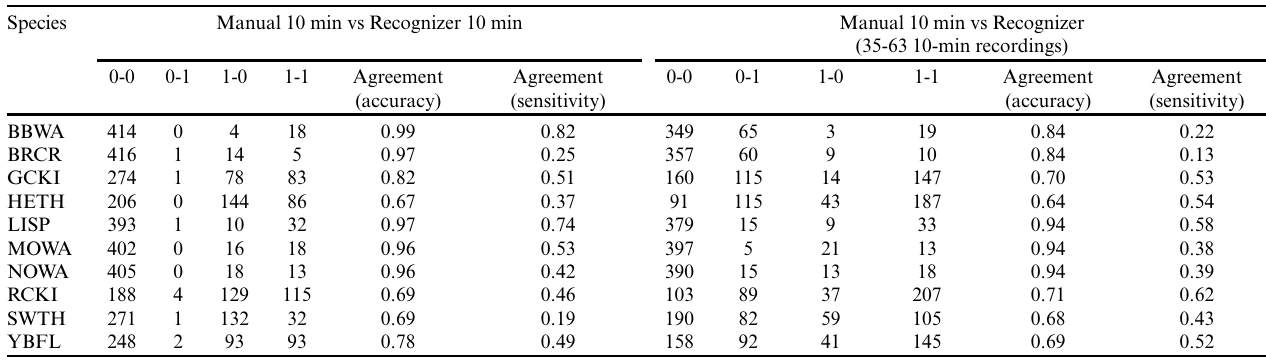
Table 7 . Summary of detection (1) and nondetection (0) patterns for two comparisons. The first compares manually interpreted 10- minute recordings against 10-minute recordings processed by a recognizer. The second comparison contrasts manually interpreted 10- minute recordings against week-long compiled recordings (between 350 and 630 10-minute recordings). In all three methods (10-minute manual, 10-minute recognizer, and week-long recognizer) we have 436 observations of presence or absence. (0-0 = true negatives for both methods, 0-1 = false negative with manual approach and true positive for recognizer, 1-0 = true positive for manual approach and false negative for recognizer, 1-1 = true positive for both methods). As a measure of agreement between methods, we calculated accuracy and sensitivity. Accuracy was computed as the number of true positives and true negatives (0-0 or 1-1) divided by the total number of observations (109 sites x 4 visits = 436), whereas sensitivity was estimated as the number of true positives (1-1) divided by the number of true positives (1-1) and false negatives (0-1). See Table 4 for species codes.